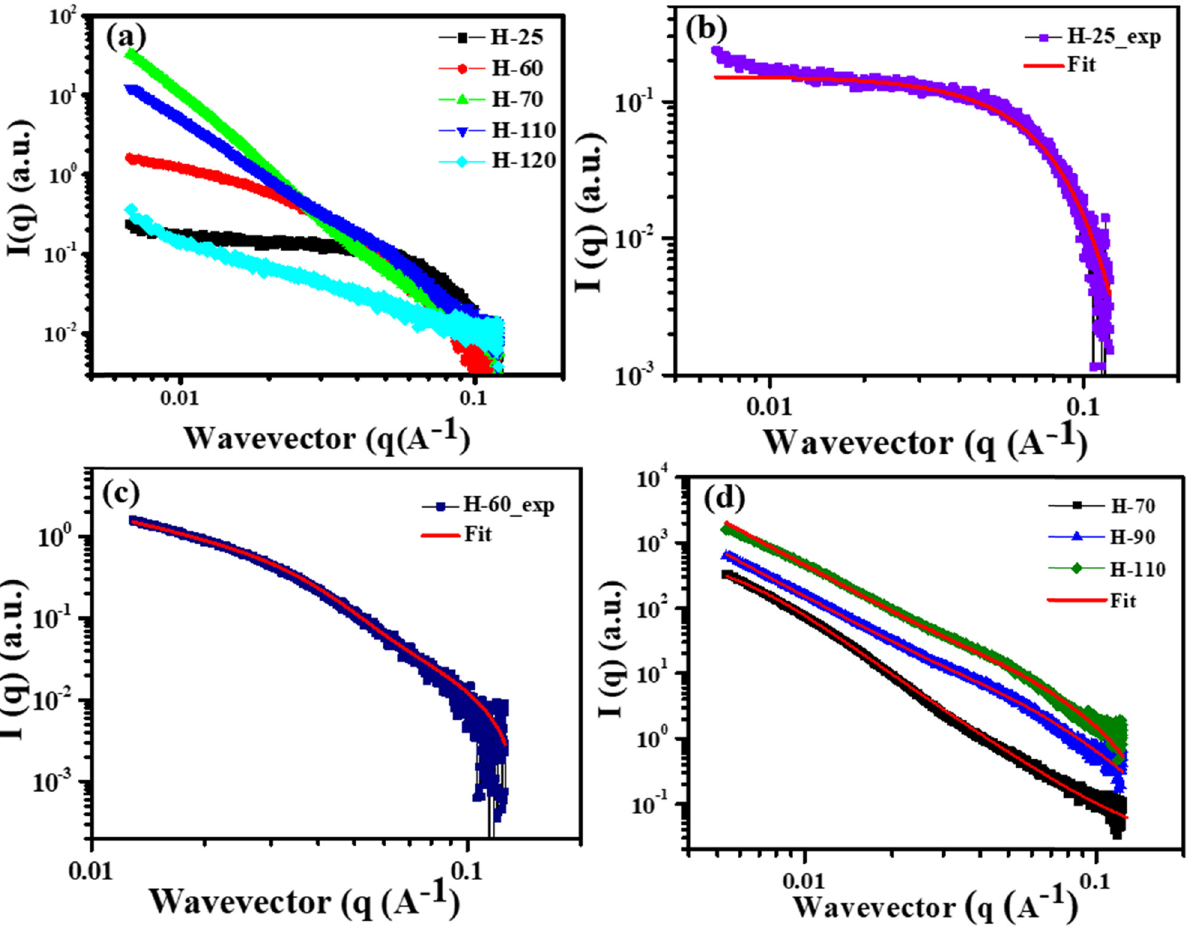
Figure 3: ( a ) Small - angle X - ray di ff raction analysis of all phases of BSA protein; ( b ) shows that fi tting of the SAXS of the H - 25 samples using the spherical model; ( c ) H - 60 is prepared near the transition temperature, SAXS for H - 60 is fi tted using the combination of Lorentz and Guinier equation; ( d ) shows the fi tting of H - 70, H - 90 and H - 110 using the Lorentz and porod fi